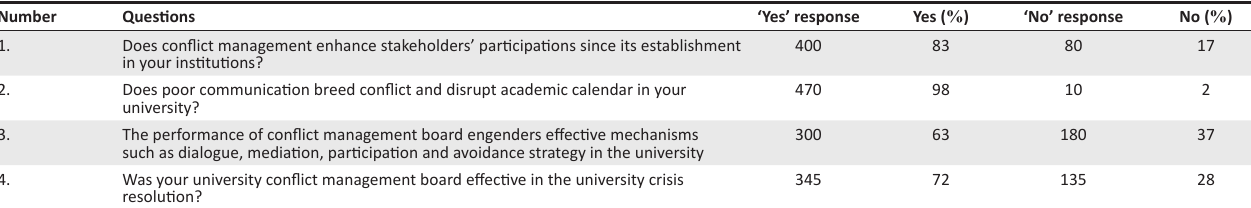
TABLE 3: Percentage of questionnaire respondents.